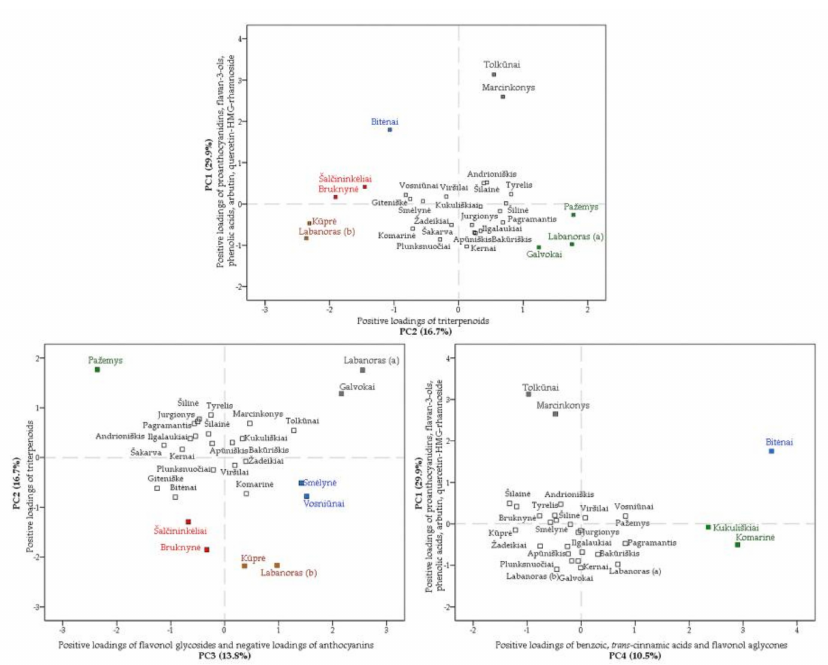
Figure 6. PCA scores estimating contents of phenolics and triterpenoids in lingonberries based on their collecting